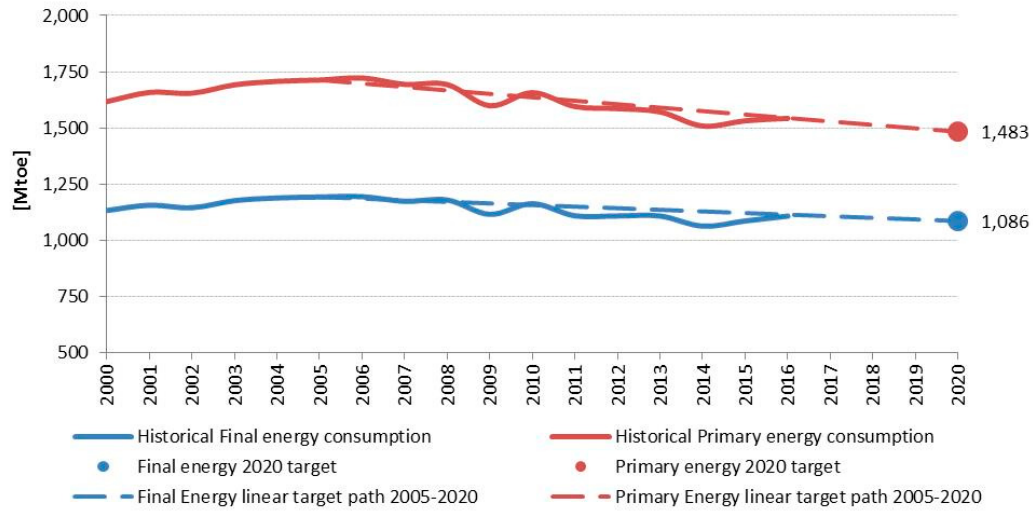
Figure 1. Primary and final energy consumption trends and 2020 energy targets in the EU-28 (in the European Union 28 Member States), 2000–2016. Source: Eurostat.